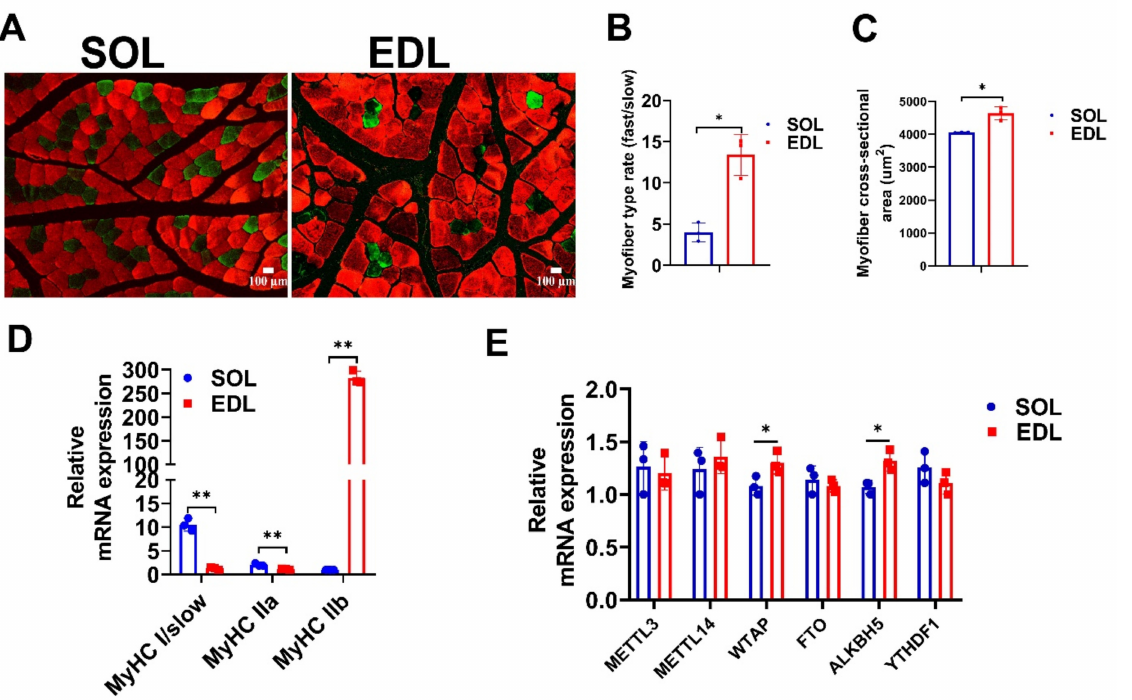
Figure 1. Detection of expression levels of muscle-fiber-type related genes and m 6 A-related genes. ( A ) Representative images of MyHC I (green) and MyHC IIb (red) immunofluorescent staining in SOL and EDL muscle sections. Scale bar: 100 µ m. ( B ) Quantification of the cross-sectional area of SOL and EDL muscle sections in ( A ). ( C ) Statistical analysis of fast and slow muscle fibers of SOL and EDL muscles in ( A ). ( D ) qPCR experiment detects the expression level of MyHC I , MyHC IIa , and MyHC IIb in SOL and EDL. ( E ) qPCR experiment detects the expression level of m 6 A-related genes METTL3 , METTL14 , WATAP , FTO , ALKBH5 , and YTHDF1 in SOL and EDL. The relative RNA expressions were standardized to that of the control gene β -actin. Data represent mean ± SD of three independent biological replicates. * p < 0.05, ** p <